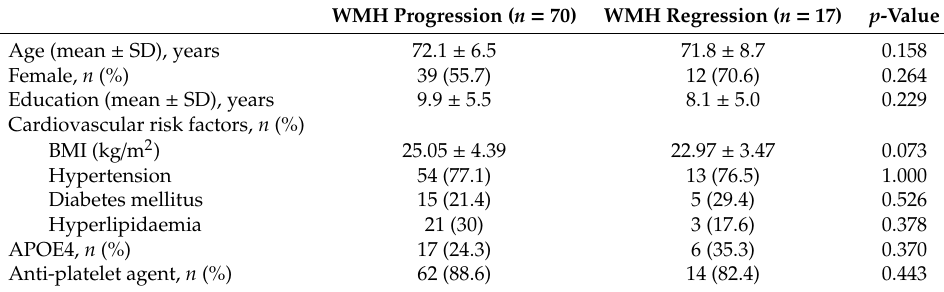
Table 1. Demographics and clinical characteristics of patients in the WMH progression and WMH regression groups at